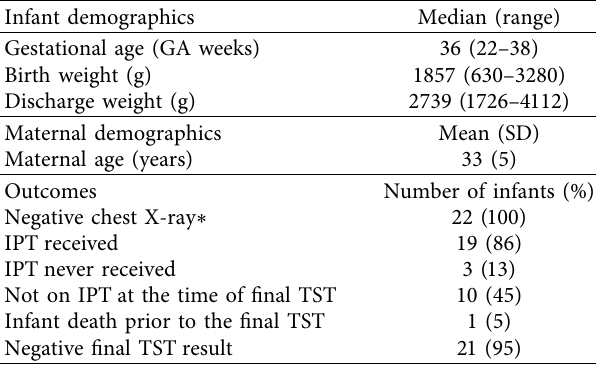
Table 1: Exposed infant and maternal demographics and infant